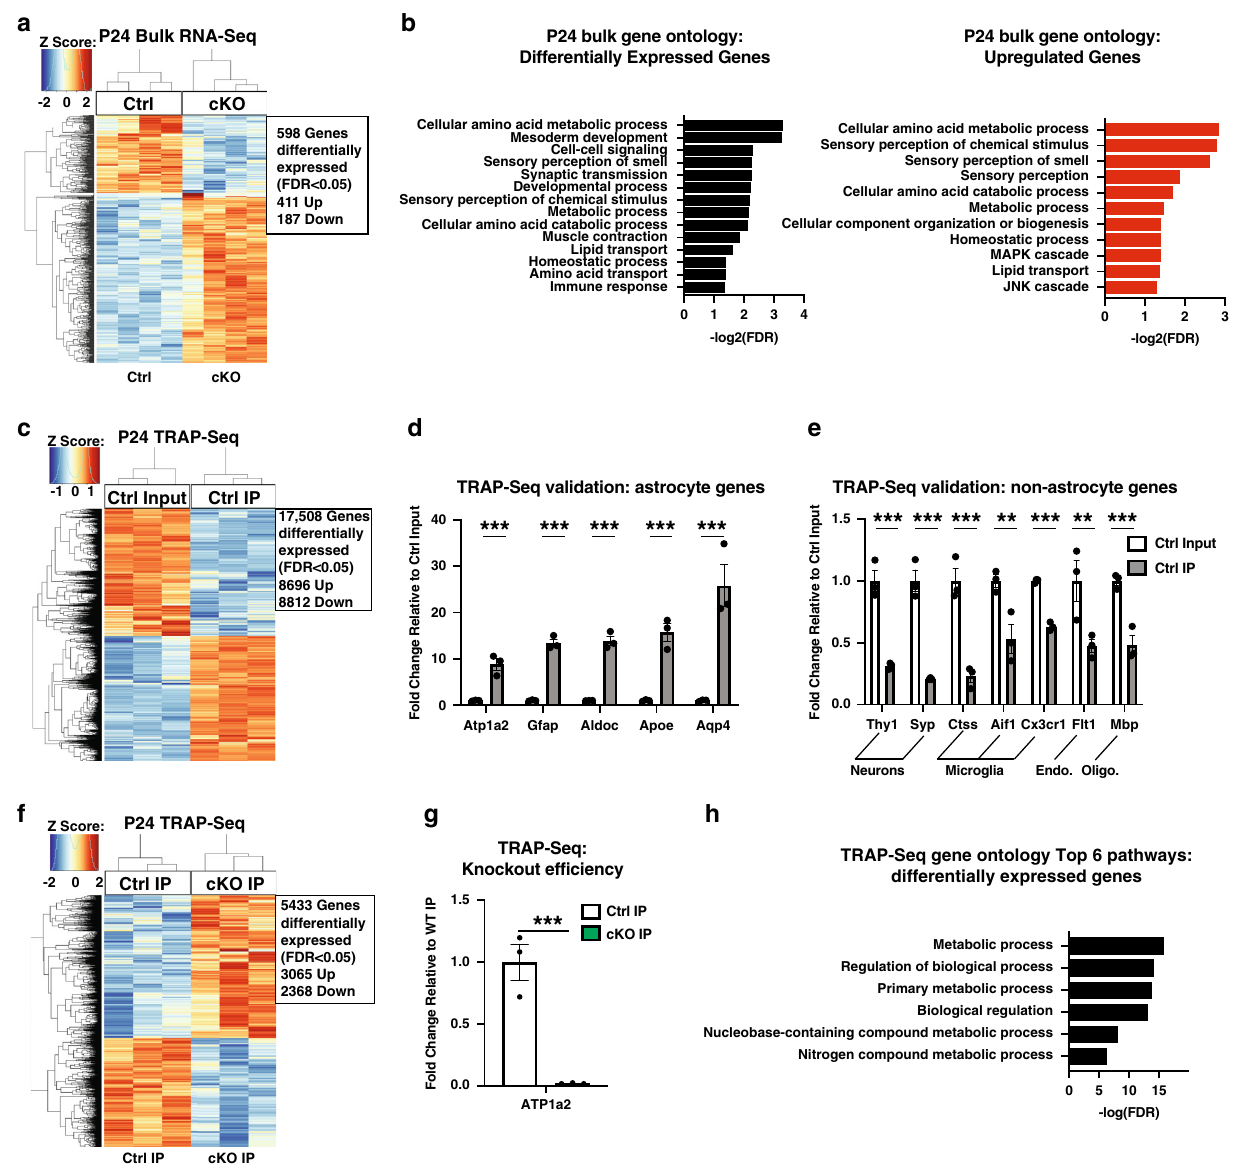
Fig. 4 Conditional α 2-Na/K ATPase knockout mice exhibit alteration of metabolic transcripts in astrocytes. a , b The cerebral cortex from P24 conditional α 2-Na/K ATPase knockout (cKO) and sex-matched littermate f/f or f/ + control (Ctrl) mice were subjected to RNA-Seq analyses ( n = 4). Clustering dendrogram and heatmap of the expression levels of signi fi cantly upregulated and downregulated genes (false discovery rate (FDR) < 0.05, n = 4 mice per group, Z -score of base 2 log-transformed CPM) ( a ). Gene ontology (GO) analyses of, from left to right, differentially expressed and upregulated genes in the P24 cKO mice ( b ). Signi fi cantly overrepresented pathways are shown (FDR < 0.05, equivalent to negative base 10 log-transformed FDR > 1.301). c – h The cerebral cortex from P24 cKO and Ctrl mice were subjected to translating ribosome af fi nity puri fi cation-Seq (TRAP) followed by sequencing (TRAP-Seq) analyses; ( n = 3 mice per group). Enrichment of canonical astrocyte marker genes and de-enrichment of canonical marker genes of other cell types in the immunoprecipitation (IP) fraction of f/f or f/ + Ctrl mice, using an antibody to GFP, relative to input for TRAP-Seq ( d , e ). Data are presented as mean ± s.e.m. *** P < 0.001 (two-tailed t test, n = 3 mice per group). Clustering dendrogram and heatmap of the expression levels of signi fi cantly upregulated and downregulated genes in the IP fraction from cKO mice compared to the IP fraction from sex-matched Ctrl mice ( f ) (FDR < 0.05, n = 3 mice per group, Z -score of base 2 log-transformed CPM). Atp1a2 transcript levels in Ctrl and cKO IP samples ( g ). Data are presented as mean ± s.e.m. *** P < 0.001 ( t test, n = 3 mice per group, P = 0.0007). Top six pathways (by FDR) for GO analyses of differentially expressed genes in the P24 cKO mice relative to sex-matched littermate Ctrl mice ( h ). Signi fi cantly overrepresented pathways are shown (FDR < 0.05, equivalent to negative base 10 log-transformed FDR >